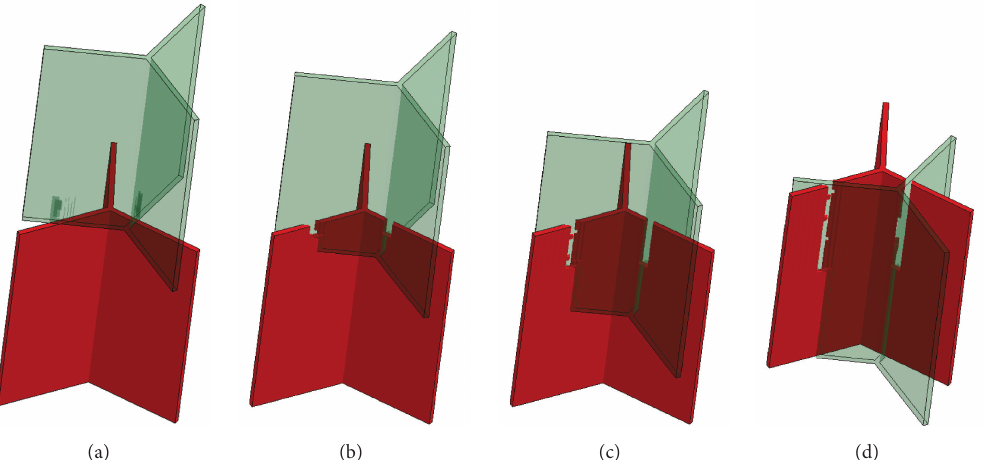
Figure 7: Semiscenogram of “Y” model for inserting process between the top and bottom samples. (a) 𝑆 = 0 mm; (b) 𝑆 = 2 mm; (c) 𝑆 = 5 mm; (d) 𝑆 = 10